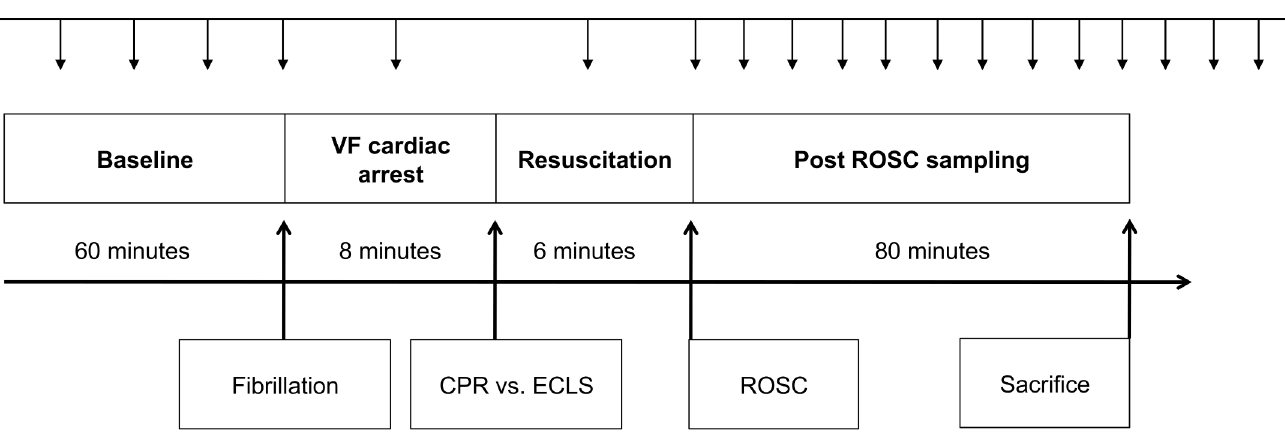
Fig 1. Timeline of the experiment. Microdiyalsis sampling interval conituously with 1 sample over 8min; Time scale is non linear to allow better overview; VF, ventricular fibrillation; ROSC, return of spontaneous circulation; CPR, cardiopulmonary resuscitation; ECLS, extracorporeal cardiopulmonary life